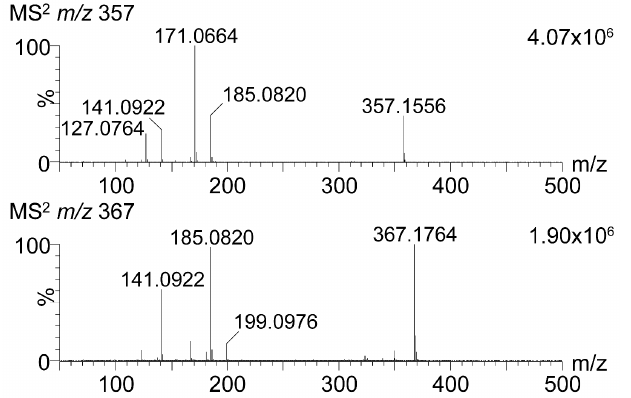
Figure 2 Figure 2. High-resolution tandem mass spectrometric data of m / z 357 (C 17 H 25 O 8- , top panel) and m / z 367 (C 19 H 27 O 7- , bottom panel) ions detected in laboratory-generated α -pinene/O 3 sample.